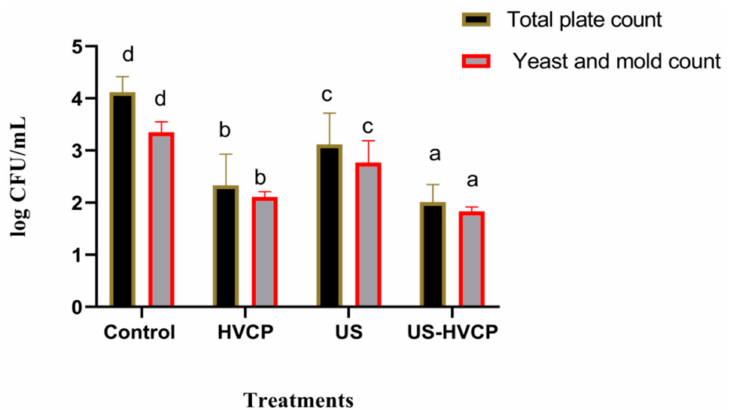
Figure 3. Combined treatment e ff ect of US and HVCP on the microbial activity of carrot